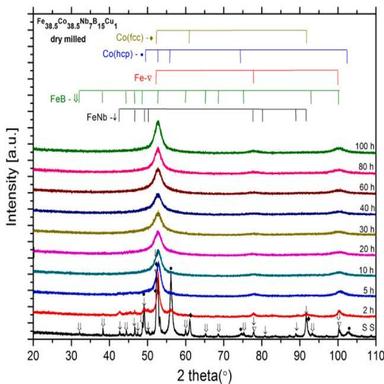
X-ray diffraction patterns at room temperature of the starting sample (noted SS) and of the Fe38.5Co38.5Nb7B15Cu1 dry-milled samples up to 100 h. For clarity, the XRD patterns have been shifted vertically.